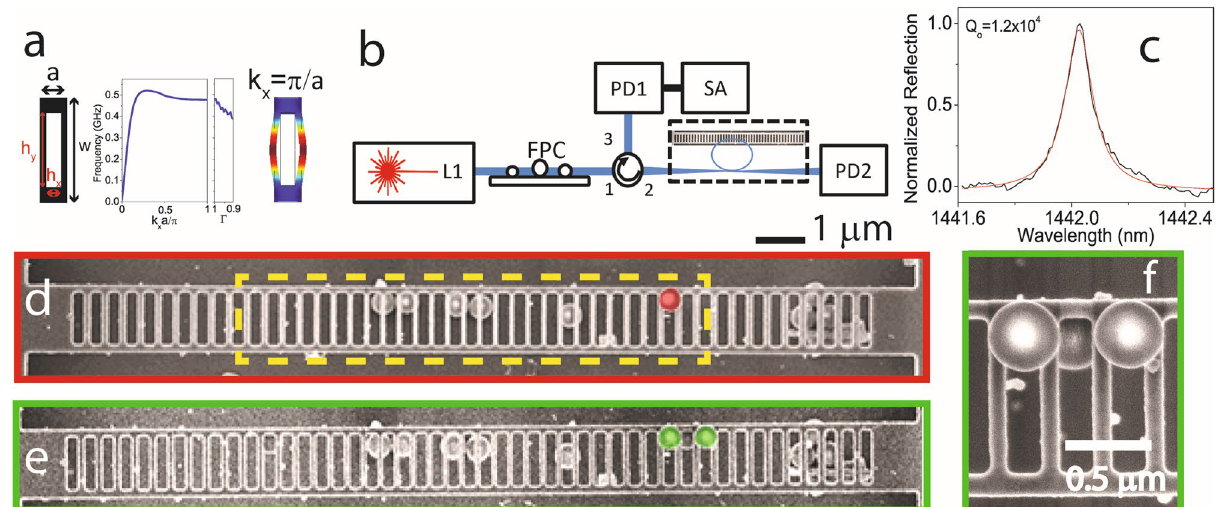
Figure 1. Optomechanical crystal geometry and experimental setup. ( a ) Left. Sketch of the unit cell of the OMC. The nominal geometrical parameters are a = 362 nm, w = 1396 nm, h y = 992 nm, h x = 190 nm and thickness = 250 nm. Centre. Band diagram of the pinch mechanical band and dependence of the X-point band edge energy on the reduction factor. Right. Deformation profile of the pinch mode at the X-point calculated with a FEM solver. The simulations have been performed by importing single mirror cells of the fabricated geometry and applying Floquet periodic conditions. ( b ) Experimental setup used for the optomechanical characterization of the fabricated OMCs. ( c ) Reflection spectra around the first optical resonance of the OMC. ( d , e ) SEM micrographs of the characterized OMCs with one and two submicrometer particles on top and have been highlighted in red and green, respectively. The cavity region is delineated by a dashed yellow box in ( d ). ( f ) Zoom of the region of the OMC holding the particles. The diameter of the particles is 495 ± 16